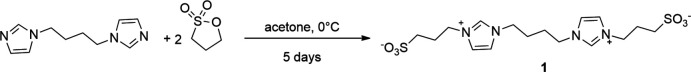
Synthesis scheme of 1.